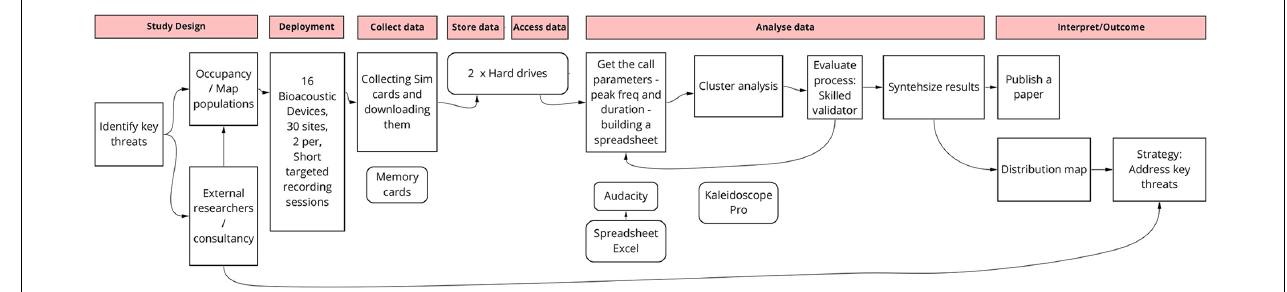
FIGURE 1 | An example ecoacoustics use case showing the flow of data between multiple organizations. The research group QUT Ecoacoustics accesses data from an ecoacoustics portal the A2O which is then shared with the Hoot Detective citizen science project.